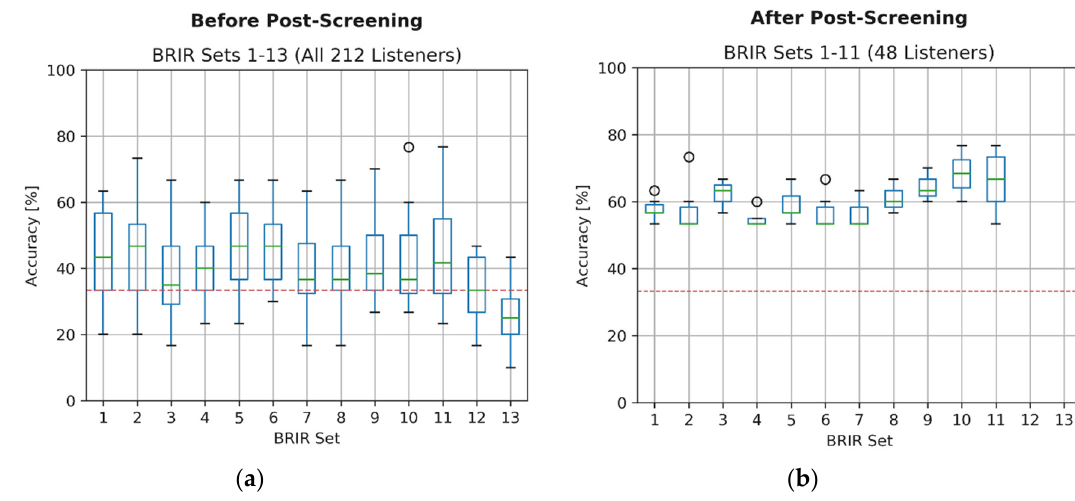
Figure 4. Boxplots of the accuracy scores for stimuli synthesized using specific BRIR sets: ( a ) before post-screening; ( b ) after post-screening. Red line denotes no-information